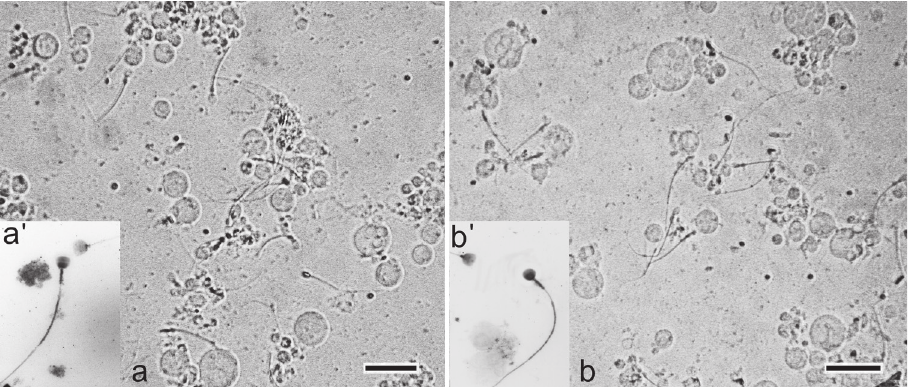
Figure 3. a–b Cell suspension of common shrew testis a – homozygote (the Moscow race) b – complex heterozygote from interracial hybrid zone a’, b’ Inverted image of spermatozoa (non-specific binding of anti-SCP3 antibodies after immunocytochemistry). Bar = 20 table 1. SC analysis in chromosomal hybrid zones of the common shrew.